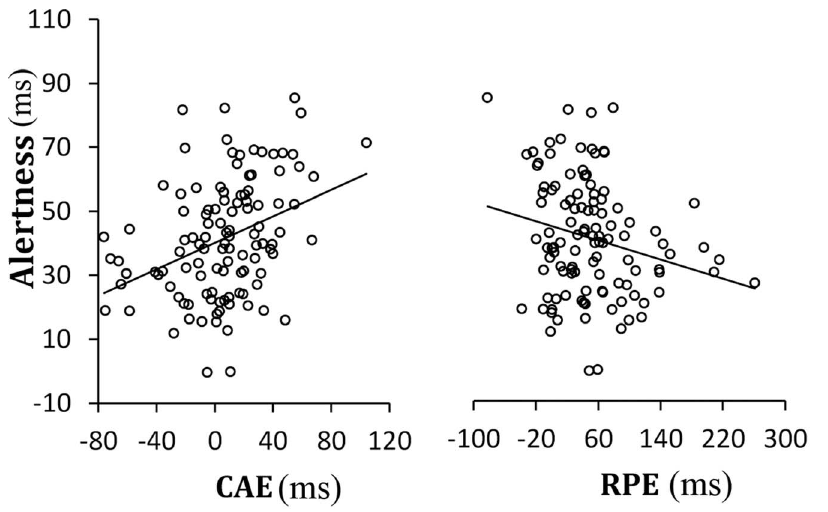
Figure 1. Scatter distribution in experiment 1. Curve fit between the efficiency of alertness and the CAE, alertness and the RPE, alertness and the congruency effect, respectively. NB. CAE = conflict adaptation effect on change trials; RPE = repetition priming effect on response or stimulus- response (S-R) repetition trials.